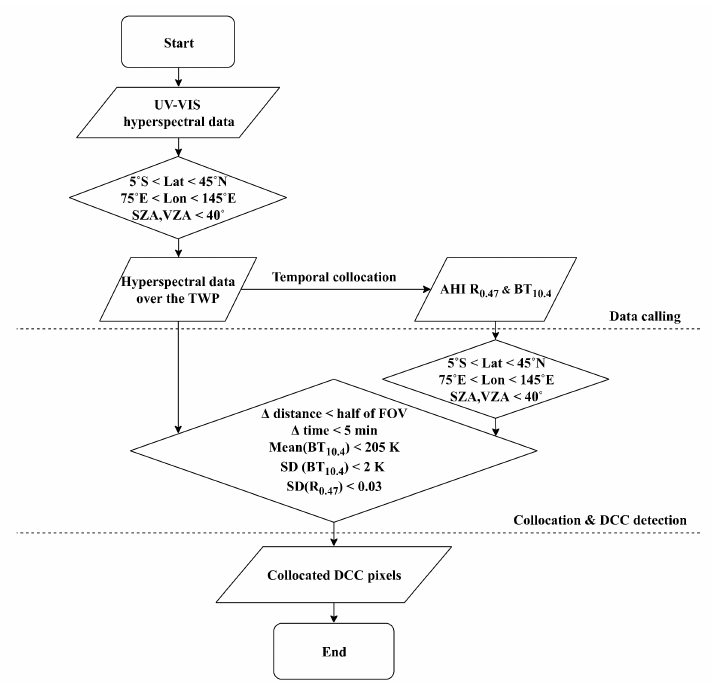
Figure 3. Flow chart of the collocation process between a UV–VIS hyperspectral sensor and a VIS–IR imager for the generation of DCC data. Mean and standard deviation (SD) are calculated with AHI pixels satisfying the spatiotemporal collocation